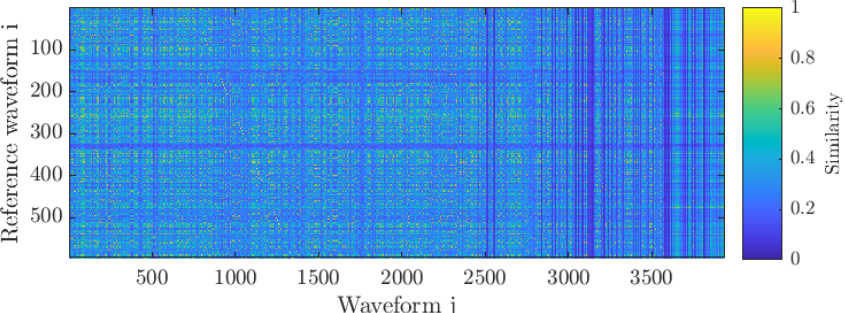
Figure 10. Similarity matrix with reference ‘noise’ waveforms correlated with the rest of data. Note the faint diagonal line between 𝑗 = 800 to 𝑗 = 1300, indicating autocorrelation.